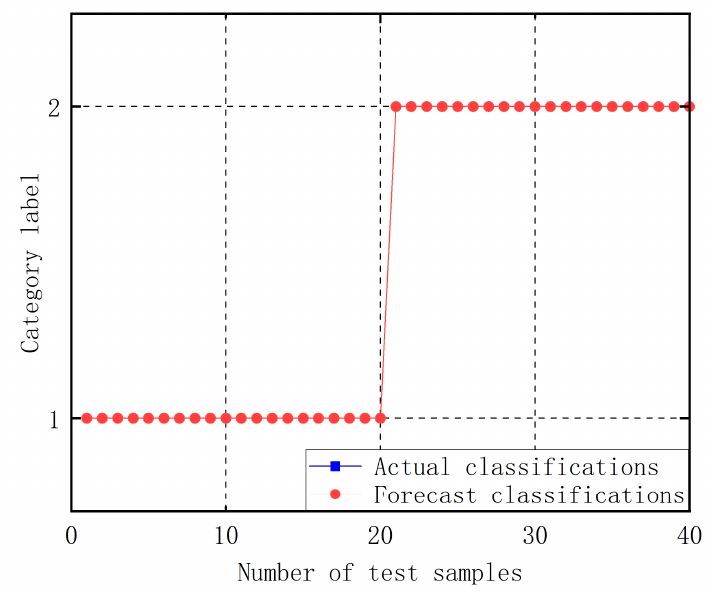
Figure 6. Anchor smash fault identification results based on the VMD-Volterra-SVM method.